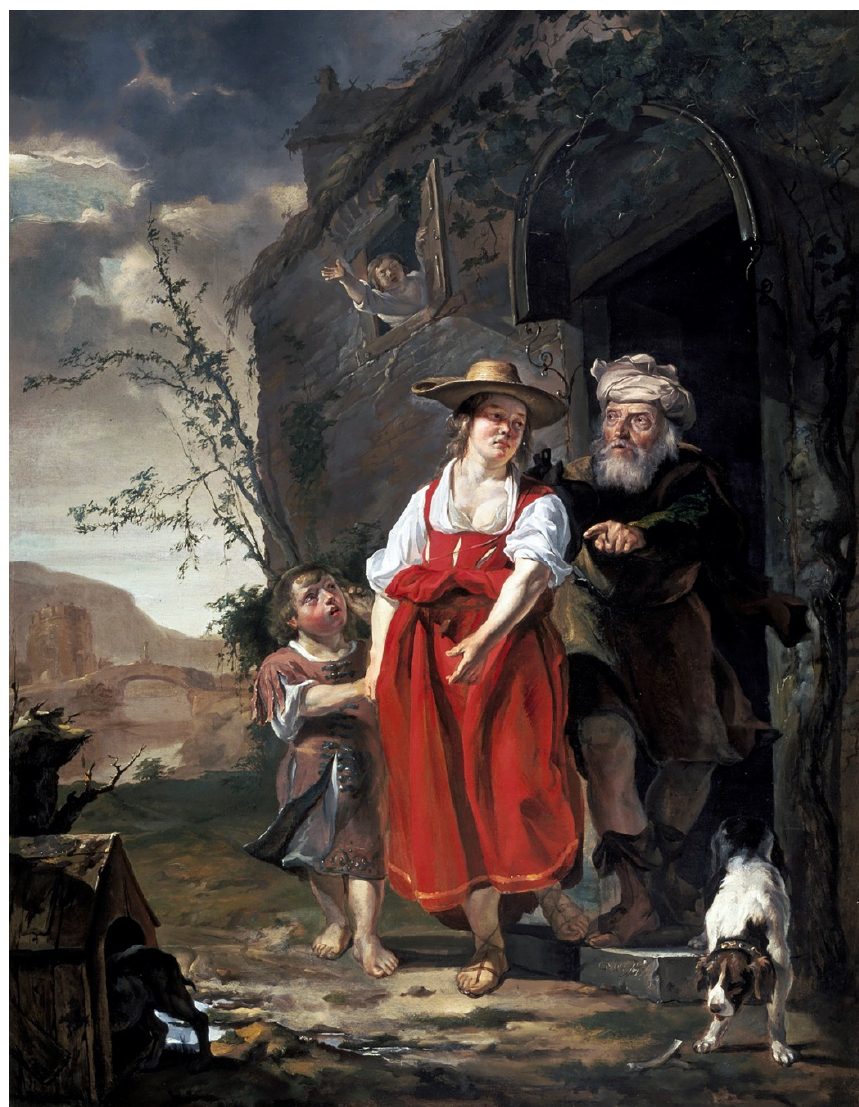
Figure 14. Gabriel Metsu, ca. 1653. Leiden, Stedelijk Museum De Lakenhal.